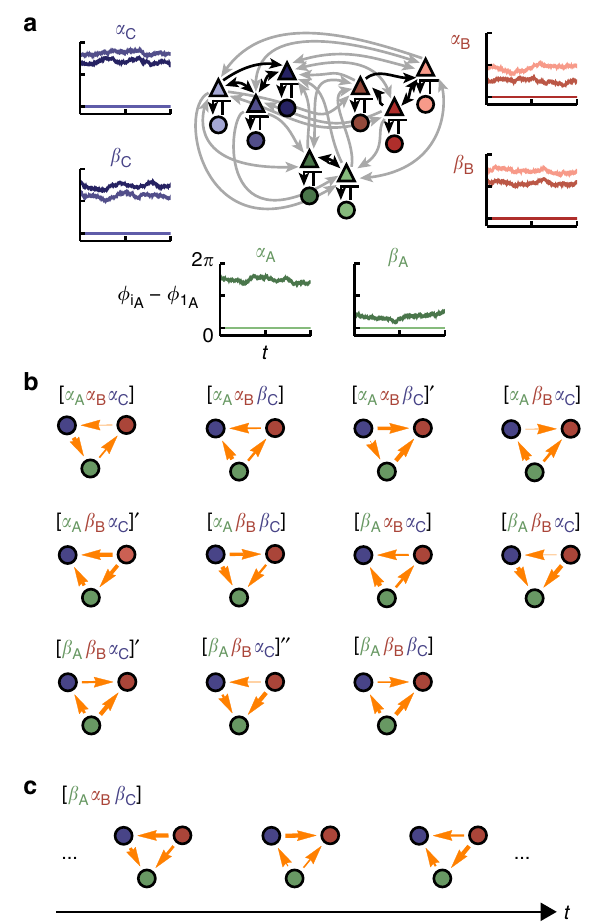
Figure 4 | Combinatorially many IRPs in networks with locally multi- stable dynamics. ( a ) Modular circuit as in Fig. 1e. Without inter-module coupling (grey arrows), each of the M ¼ 3 communities X A { A , B , C } exhibits multi-stability between two phase-locked configurations, denoted as states a X and b X (insets). The characteristics of these states remain present in the full network once weak coupling between the modules is introduced. We refer to these states as local dynamical states D X . ( b ) Information routing patterns (IRPs) between the hierarchically reduced sub- networks for different combinations of the local dynamical states